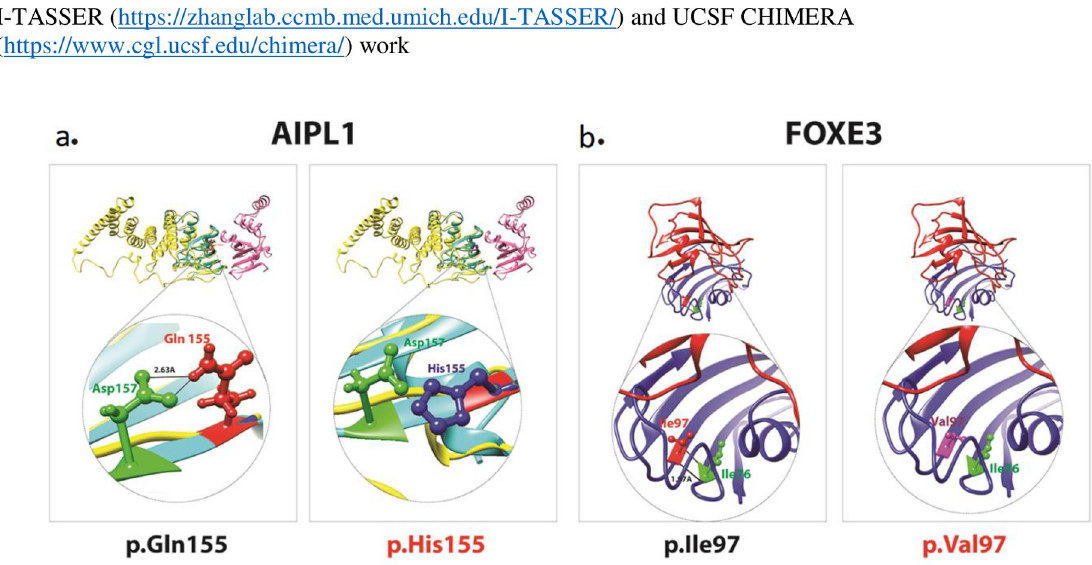
Fig 2. Protein 3D structural modeling of variants identified in this study. Structures of both wild type and mutated residues (red) are shown. Solid black lines represent the interactions with neighboring amino acids. Ball and stick representation in red shows wild type residue, while the blue and purple represent mutated amino acids. (a) The p.(Gln155His) variant of AIPL1 is predicted to cause loss of hydrogen bond with p.(Asp 157) impacting protein 3D folding and introduces torsion in the mutated protein. (b) The p.(Ile97Val) variant in FOXE3, is predicted to cause loss of ionic interaction and impact proper protein folding. The Isoleucine (Ile) at position 97 is predicted to form a hydrogen bond with p.Ile76, which is lost due to replacement with valine at position